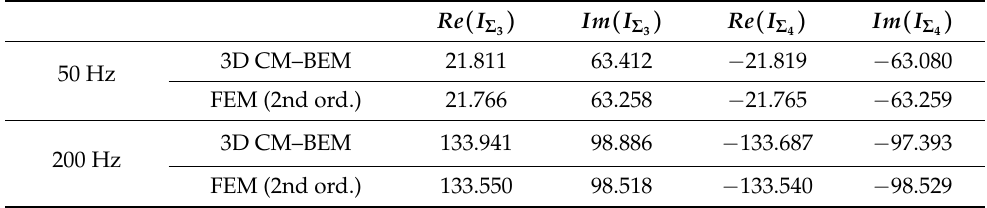
Table 2. Real and imaginary parts of eddy–current (A) computed through cut surfaces Σ 3 , Σ 4 by 3D CM–BEM and 3D FEM (2nd) at 50 Hz and 200 Hz